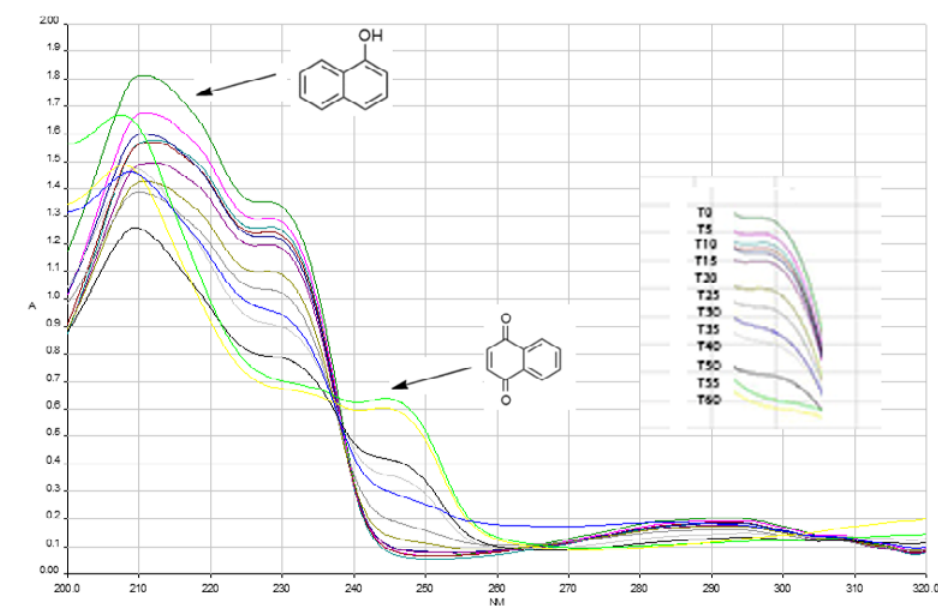
/SSA degradation reaction at specific times (0-60 2